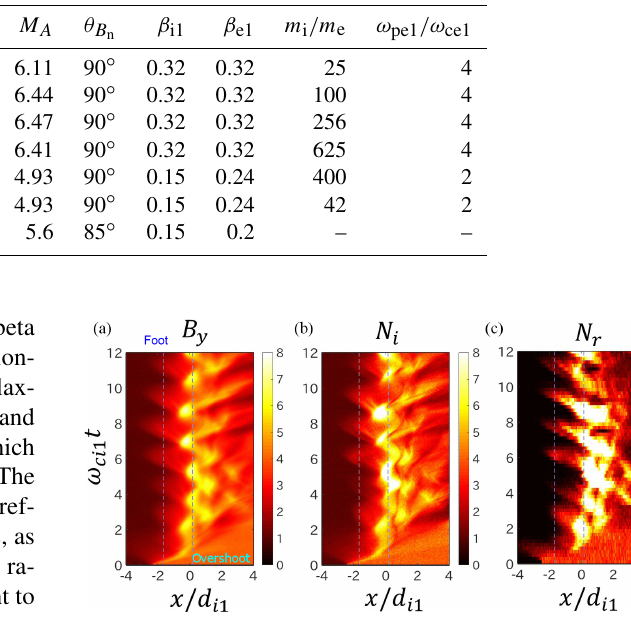
Figure 1. Development of a perpendicular shock for Run A with the small simulation domain. Tangential component of the shock magnetic field B y at y/d i1 = 0 . 5 as a function of position x and time t (a) , and the corresponding ion density (b) and density of reflected ions (c) . The position and time are renormalized by the ion inertial length d i1 = c/ω pi1 and the ion cyclotron angular period 1 /ω ci1 , respectively. The magnitudes of the magnetic field and the density are normalized by the initial upstream magnetic field B 01 and the initial upstream density n 1 . The positions of the shock foot and overshoot used in Figs. 3 and 4 are indicated by the dashed